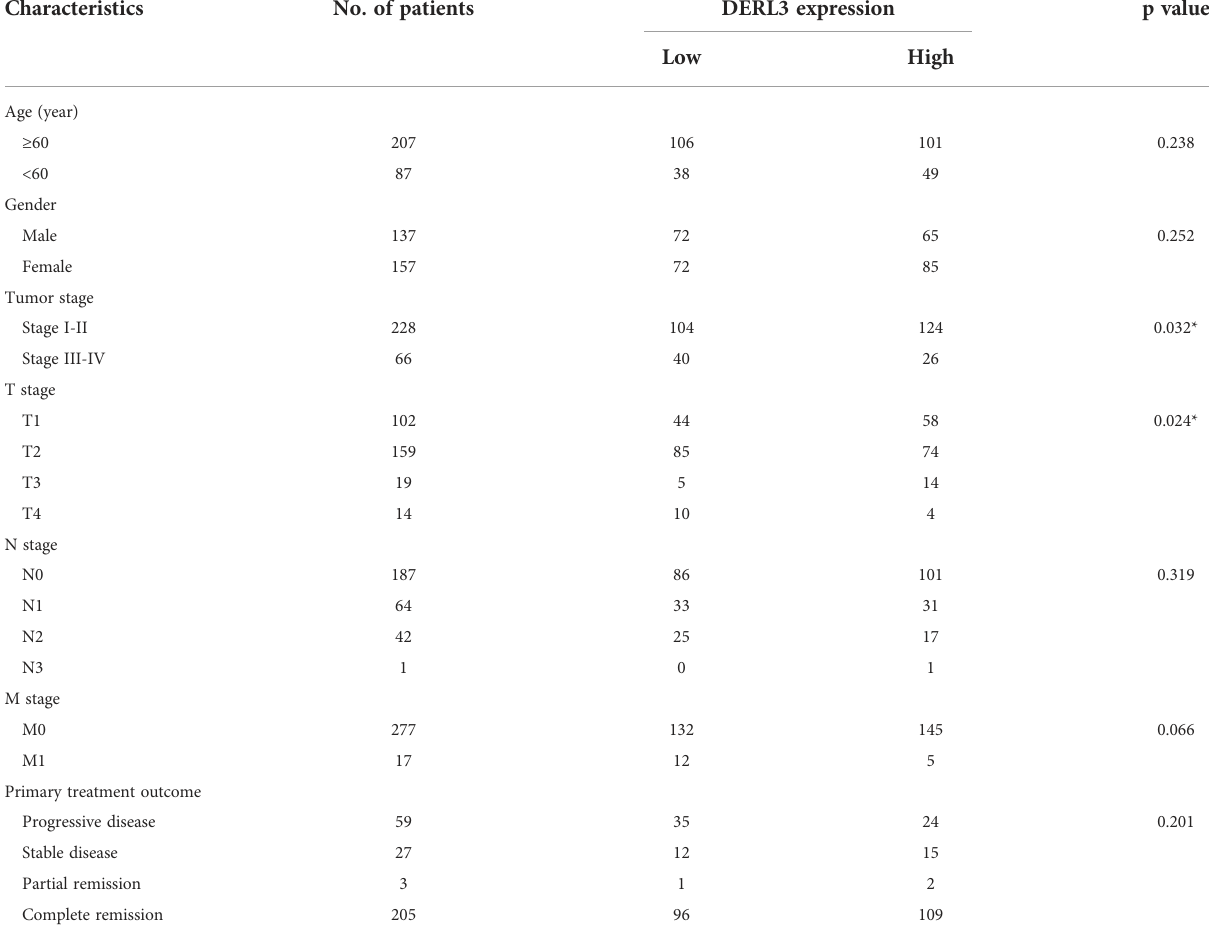
TABLE 1 Correlation of DERL3 expression with LUAD clinicopathological